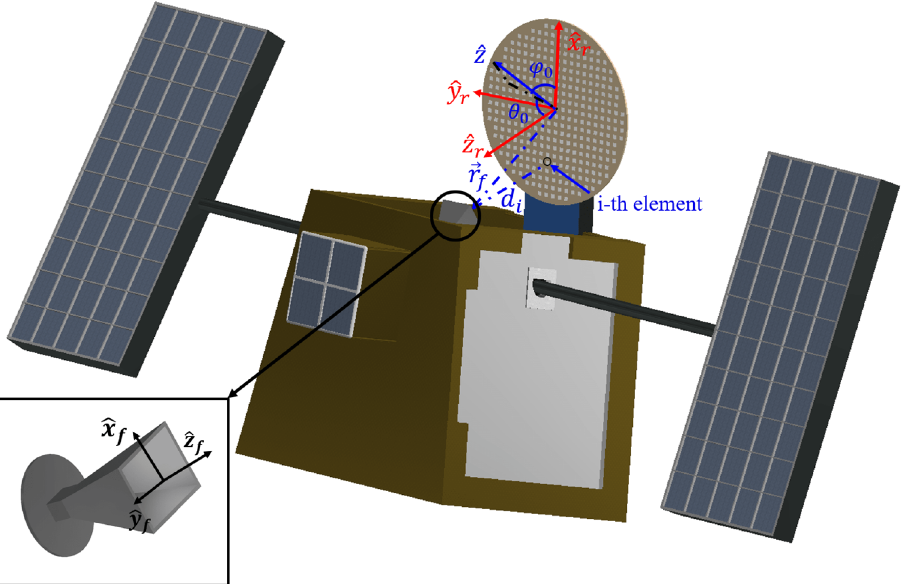
Figure 1. Sketch of the reflectarray mounted on a small satellite, including the diagram of the antenna optics under consideration. The reflectarray is elliptical and comprised of microstrip patches of variable size. The feed horn is placed in the XZ plane of the reflectarray coordinate system ( ˆ x r , ˆ y r , ˆ z r ) and generates an incident field on its surface which is reflected back by the